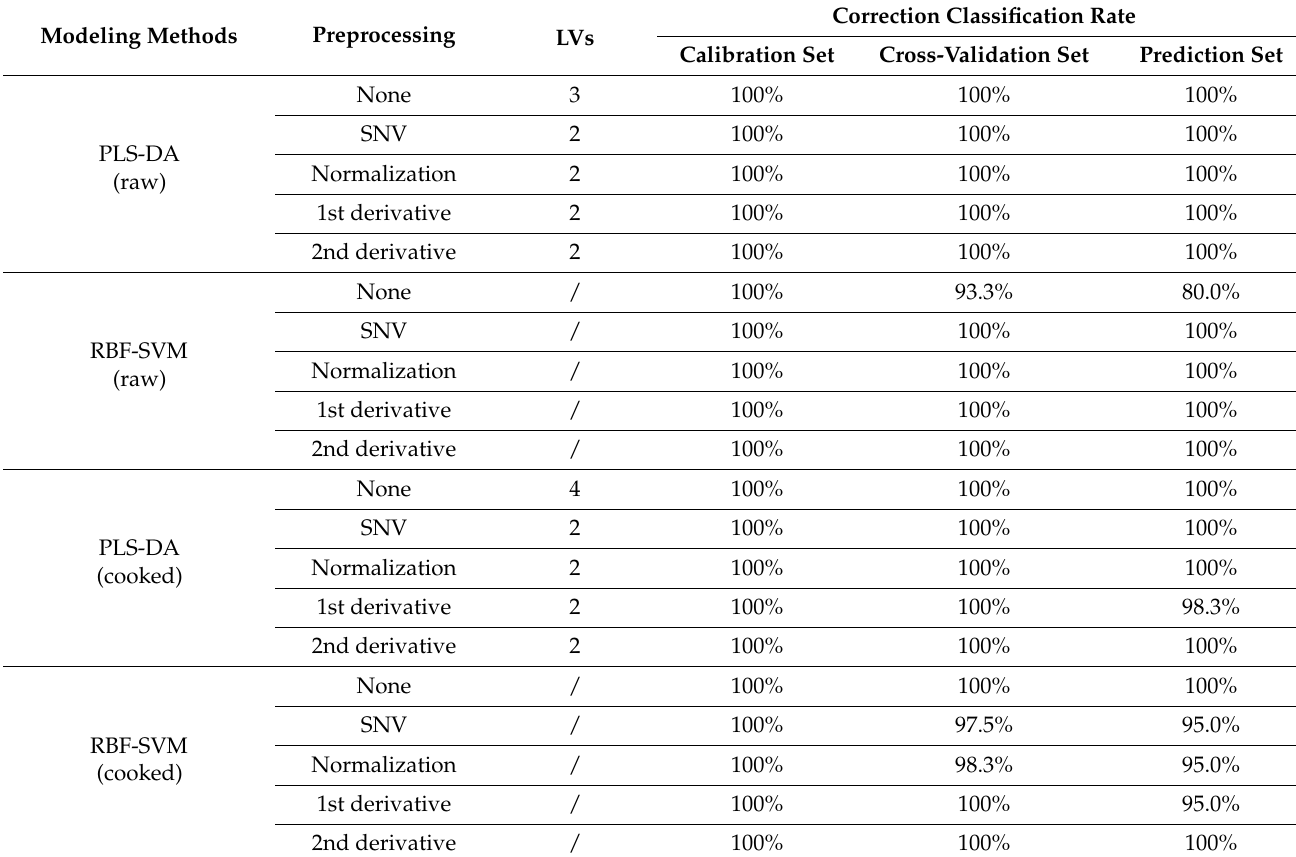
Table 1. Model performances for identifying raw and cooked meat rolls based on various preprocessings and modeling methods applied to full spectra, PLS-DA: partial least square-discriminant analysis; RBF-SVM: radial basis function-support vector machine; SNV: standard normal variable; LVs: latent variables. Modeling